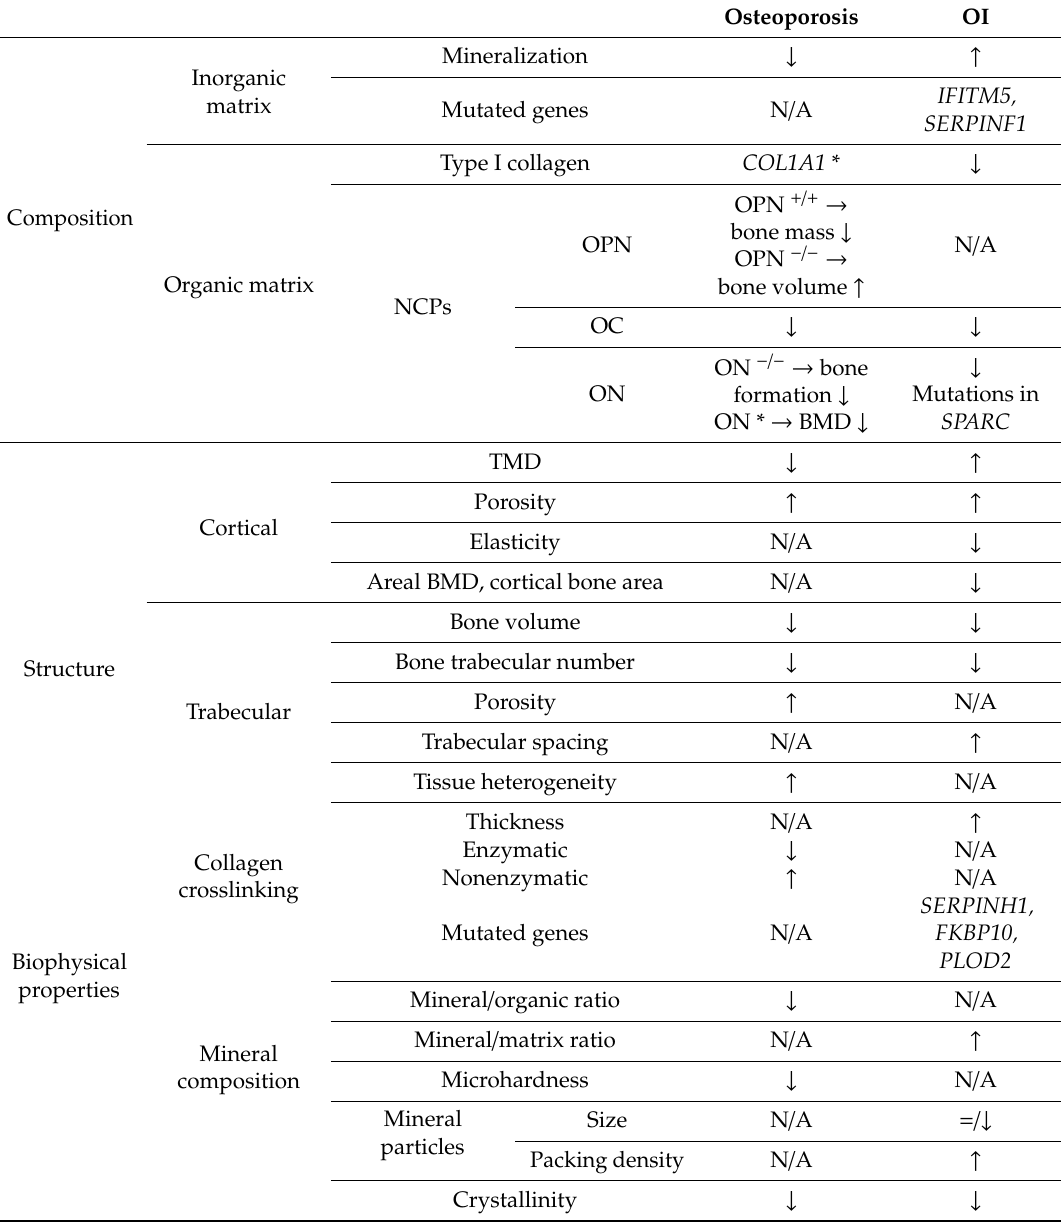
Table 1. Alterations in extracellular matrix (ECM) composition, structure and biophysical properties in osteoporosis and osteogenesis imperfecta